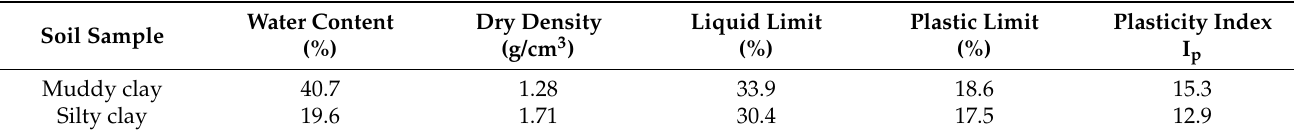
Table 1. Physical and mechanical parameters of